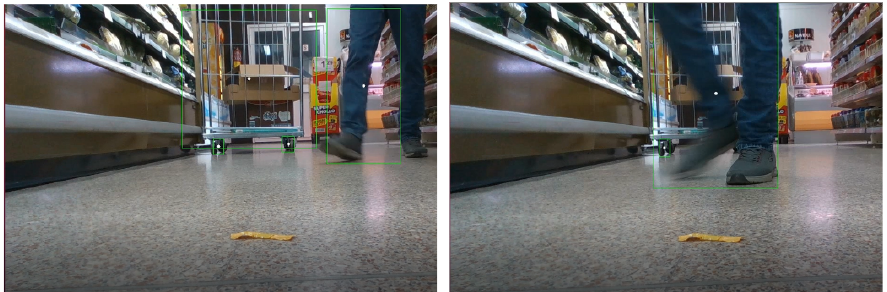
Figure 10. The system detects the presence of a person walking close to the roll container. Images show that the system detects people and roll containers, but also the wheels of the roll container. Wheels are used for determining the pose of the container.